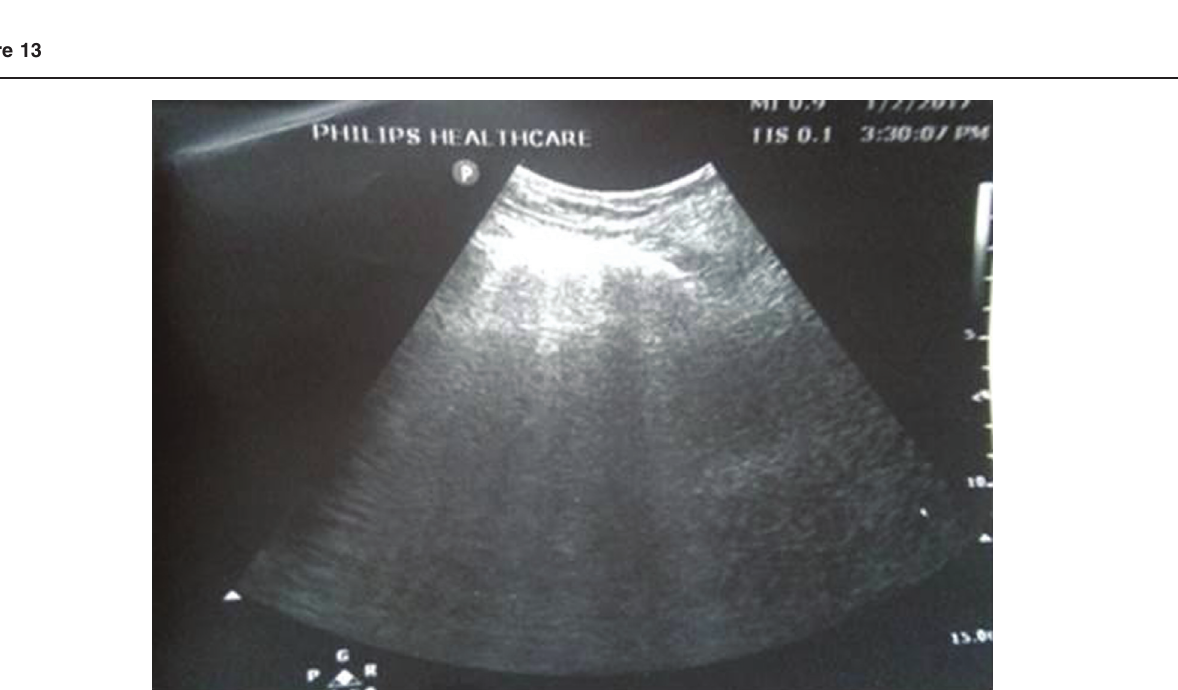
Ultrasound of a patient with mild restriction (numerous